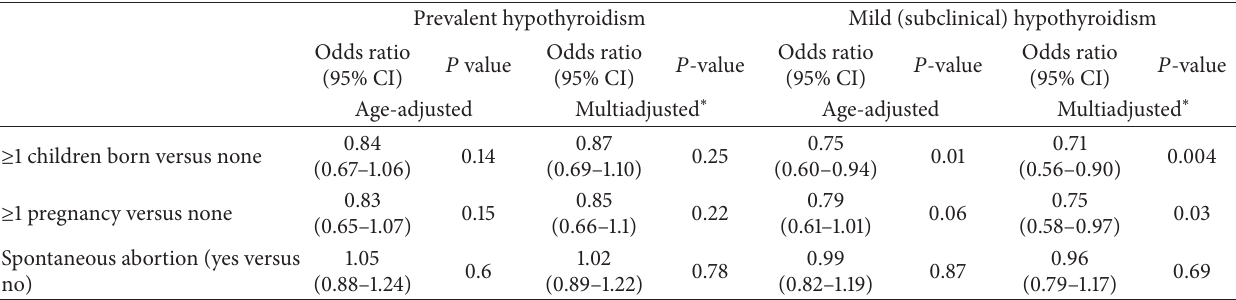
Table 3: Table of odds ratios for ≥ 1 children born, ≥ 1 pregnancy, and spontaneous abortion in patients with prevalent hypothyroidism versus controls and in patients with mild (subclinical) hypothyroidism versus